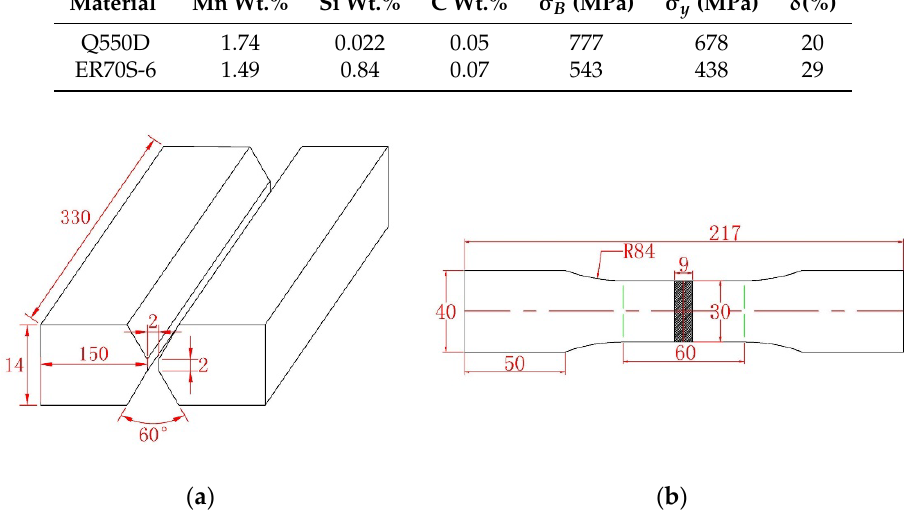
Table 1. Chemical composition and mechanical properties of the parent and deposit metal. Material